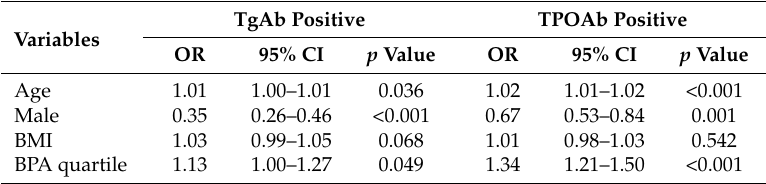
Table 2. Logistic regression analyses: predictors for TgAb or TPOAb positive.